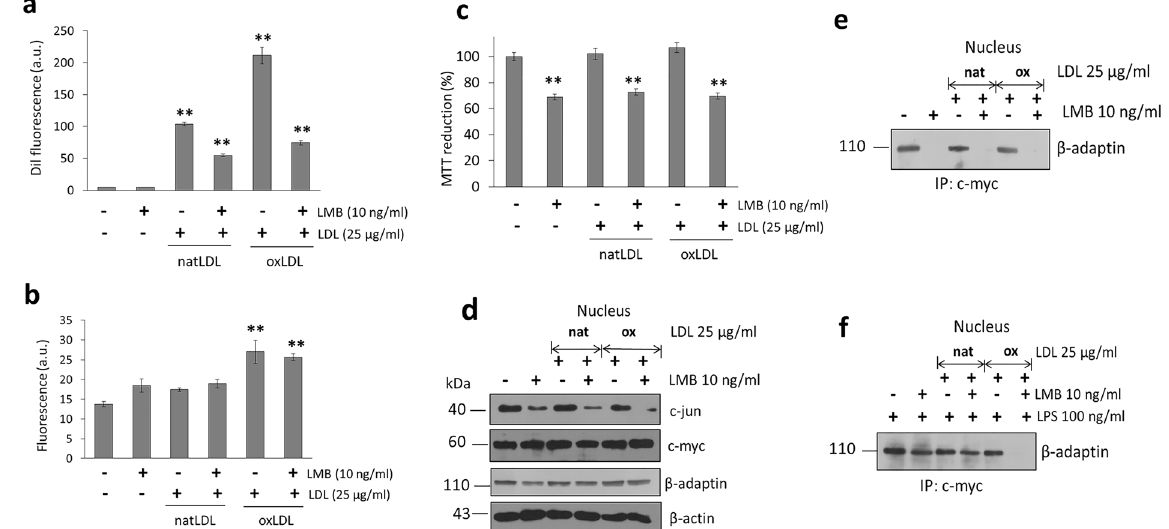
Figure 6. Inhibition of nuclear-cytoplasmic transport modifies the internalization of oxLDL, associated with disruption of the interaction c-Myc and β -adaptin. ( a ) Effect of LMB treatment (4 h) on internalization of dil- fluorescent natLDL and oxLDL in macrophages. ( b ) Under the same conditions, ROS characterization was performed. ( c ) Evaluation of cell viability by the MTT assay. ( d ) Western blot detection of c-Jun, c-Myc and β -adaptin under the treatment with LMB, natLDL and oxLDL. ( e ) Characterization of β -adaptin and